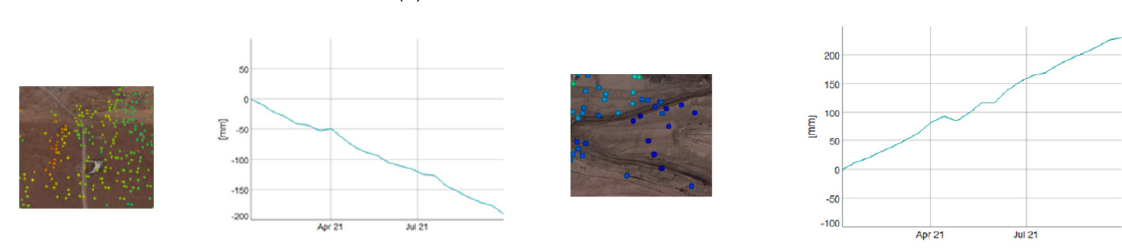
Figure 7. Deformation after landfill and three typical sites in the Muli mine.